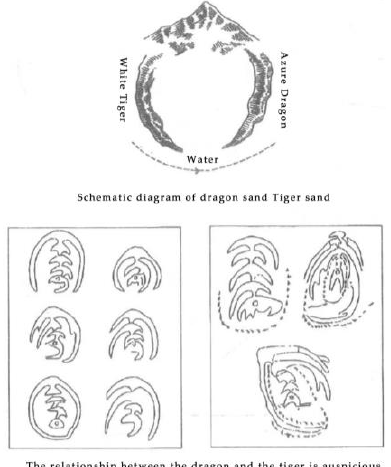
Figure 5. Diagram of the Long–Hu Sand Feng Shui pattern.